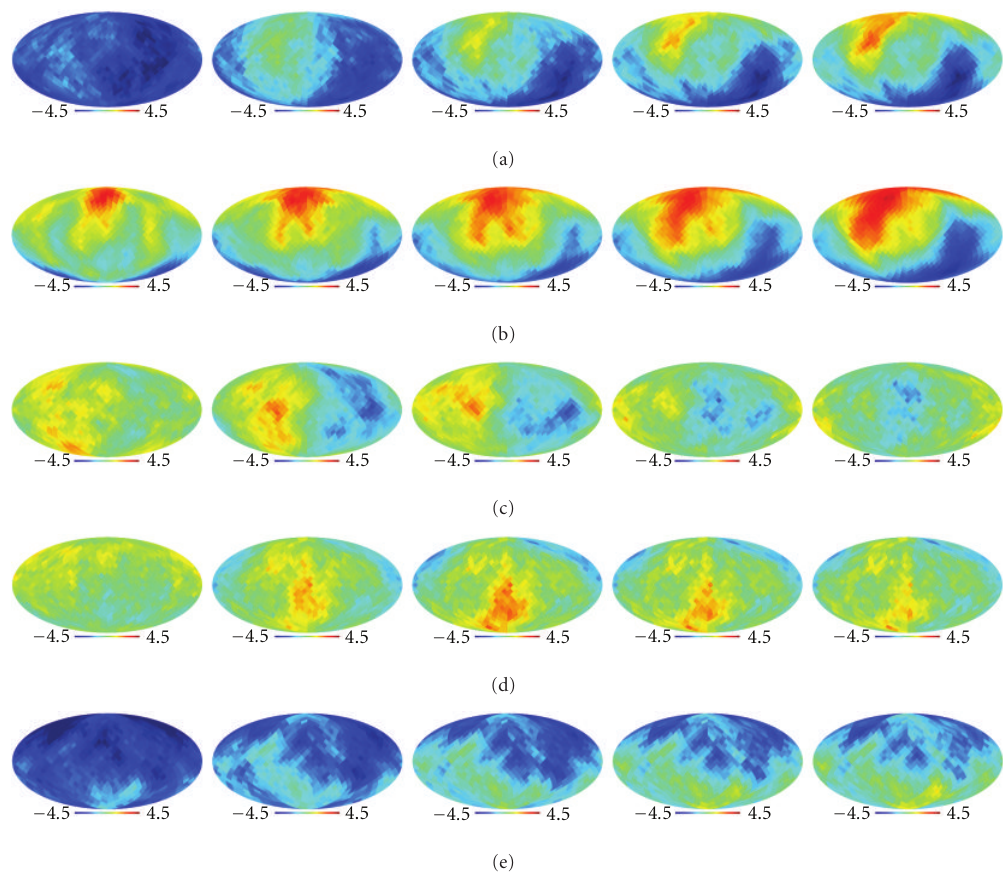
Figure 11: Deviations S ( (cid:2) α ( r k ) (cid:3) ) of the rotated hemispheres for the five scales r k , k = 2,4, ... ,10 (from left to right) for the ILC7 map and for Δ (cid:9) = [2,1024], Δ (cid:9) = [2,20], Δ (cid:9) = [20,60], Δ (cid:9) = [60,120], and Δ (cid:9) = [120,300] (from top to